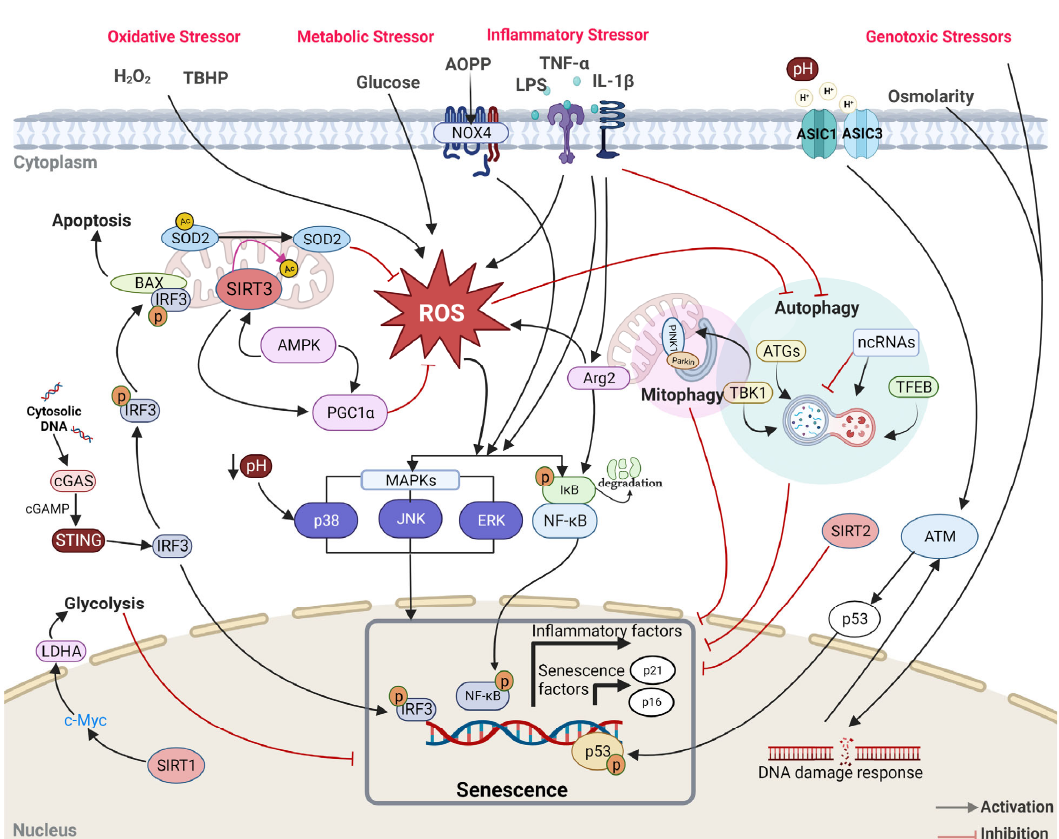
Figure 3. Proposed signaling pathways during cellular senescence activation in intervertebral discs based on reported findings. Oxidative stress is one of the major factors inducing cellular senescence (CS) in intervertebral disc. Accumulation of reactive oxygen species (ROS) occurs from oxidative stress, metabolic stress such as hyperglycemia, or inflammatory stress signaling mediated through toll like receptors (TLRs) or cytokine receptors. An increase in ROS activates MAPK signaling or NF-kB signaling to induce CS and senescence associated secretory phenotypes (SASPs). Secretion of SASP factors further amplify the senescence process through cytokine receptor mediated signaling. Arginase II increases ROS production and activates NF-kB signaling. The AOPPs activate the MAPK and NF-kB signaling pathways through NOX4 to drive disc CS. The levels of sirtuins are reduced in IDD whereas activation of sirtuins is beneficial against disc degenerative changes. The SIRT1 modulates senescence through c-Myc-LDHA mediated glycolysis. The SIRT3 modulates senescence through the AMPK-PGC1 α pathway or deacetylation of SOD2. Furthermore, increase in ROS modulates the autophagic pathway thereby affecting CS. Autophagy is downregulated in IDD and several autophagy related genes (ATGs) and other signaling molecules such as noncoding RNAs (ncRNAs), transcription factor EB (TFEB), TANK binding kinase 1 (TBK1) mediated autophagy or mitophagy activation, can reduce senescence of disc cells. Genotoxic and metabolic stressors induce DNA-damage response mediated CS activation via the ATM-p53 pathway. Additionally, cytosolic DNA is sensed by cGAS leading to activation of the cGAS-STING pathway in which activation and nuclear translocation of IRF3 contributes to senescence of the disc cells. In addition, activated IRF3 induces the Bax-mediated apoptotic pathway. Change in pH activates the p38 MAPK mediated senescence pathway or is sensed by ASIC1 or ASIC3, which then directly activates the senescence pathway. For clarity, not all signaling pathways relating to disc CS are included in this figure. Please refer to text for details. AOPPs; Advanced oxidation protein products, ASIC; Acid-sensing ion channels, AMPK; AMP-activated protein kinase, IDD; intervertebral disc degeneration, PGC1 α ; Peroxisome proliferator-activated receptor- γ coactivator 1 alpha, IRF3; Interferon regulatory factor 3. (Figure created with BioRender.com, accessed on 8 March